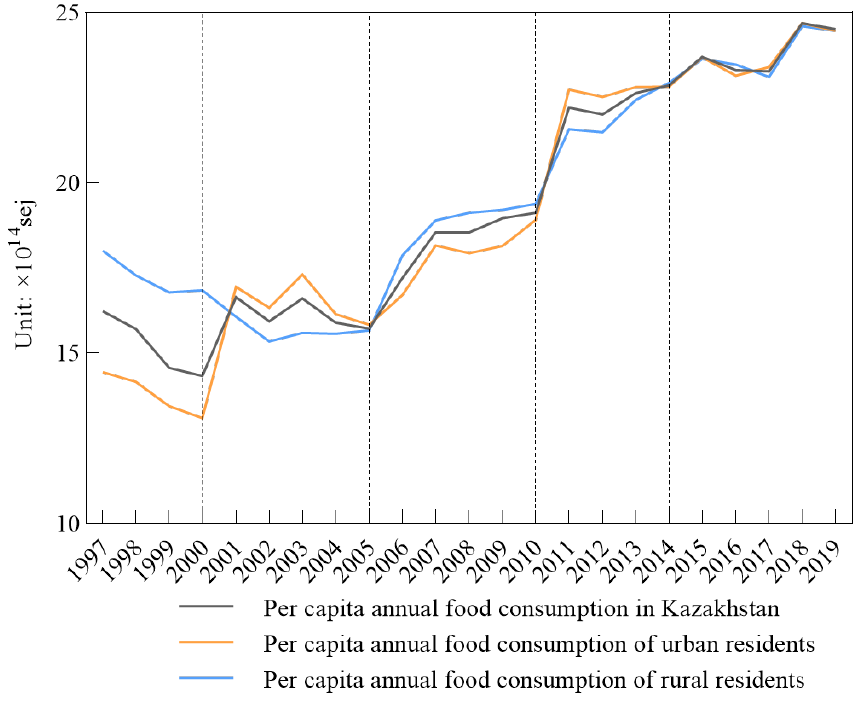
Figure 3. Per capita annual food consumption.